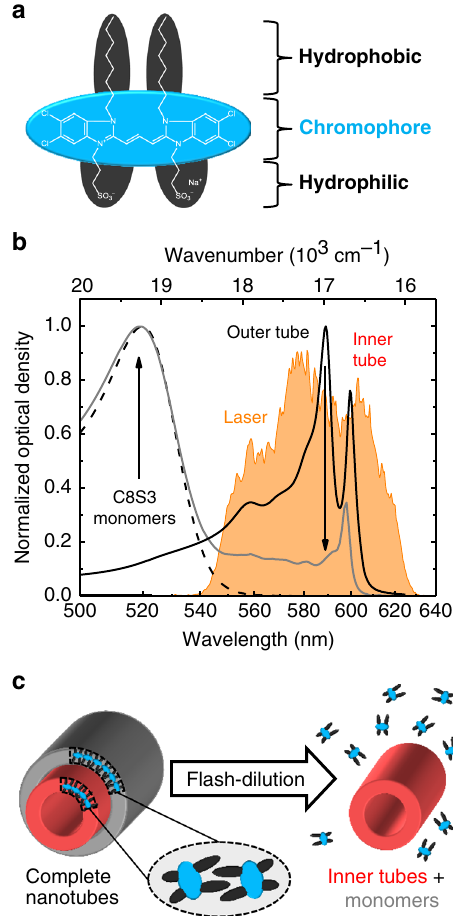
Fig. 1 Investigated system and absorption spectra before and after fl ash- dilution. a Molecular structure of the C8S3 molecule with the chromophore and functional side-groups highlighted in light blue and dark gray, respectively. b Linear absorption spectra of neat nanotubes (black solid line), isolated inner tubes (gray solid line), and dissolved monomers (black dashed line) in methanol. The laser excitation spectrum (orange) is shown for comparison. Arrows indicate spectroscopic changes upon fl ash-dilution. c Schematic representation of the fl ash-dilution process that selectively strips the outer tube, while leaving a suf fi cient share of the inner tubes intact. The decreased amplitude of the peak at ~600 nm indicates partial dissolution of inner tubes. The dissolved monomers contribute to a broad absorption band around ~520nm, which is not covered by the excitation spectrum and, thus, has no consequences for ultrafast spectroscopy (Supplementary Note 2 and Supplementary Fig.